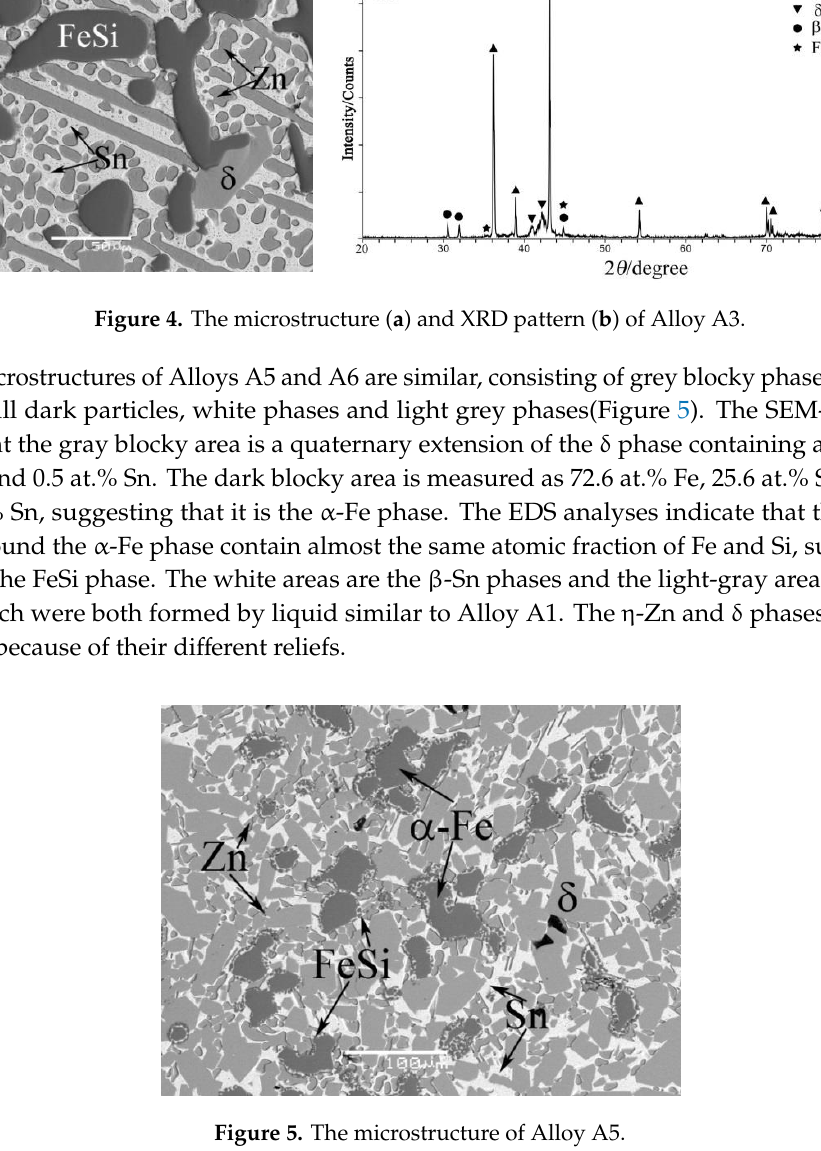
Figure 5. The microstructure of Alloy A5.